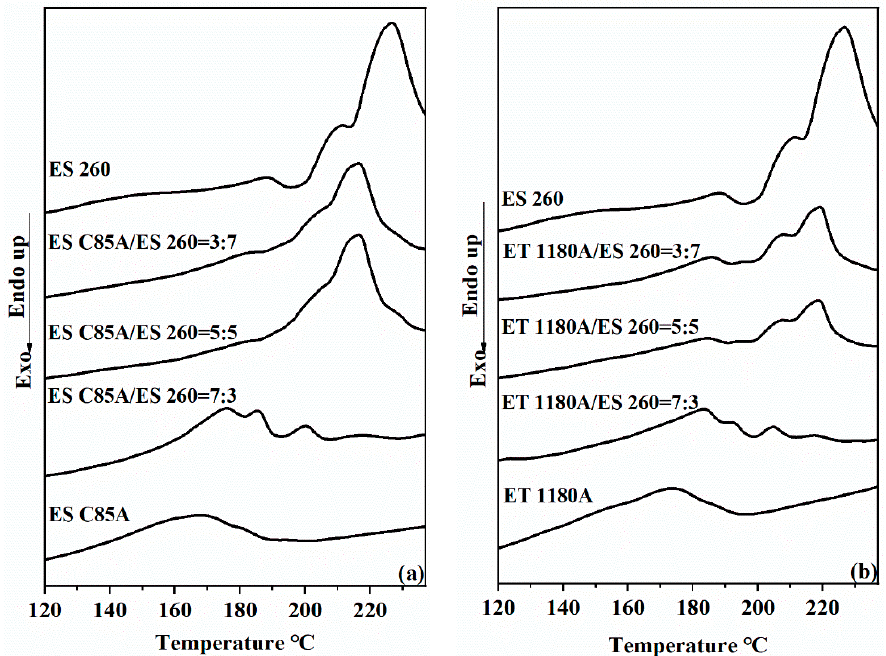
Figure 2. The melting behavior of TPU and their blends were studied with DSC during a heating process at a rate of 10 °C·min − 1 : ( a ) ESC85A/ES260 blends, ( b ) ET1180A/ES260 blends. The blend of 30% ES260 showed multiple melting peaks at much lower temperatures, indicating that the two components had good compatibility. The molecules of ES260 can follow ESC85A and ET1180A to crystallize at lower temperatures.